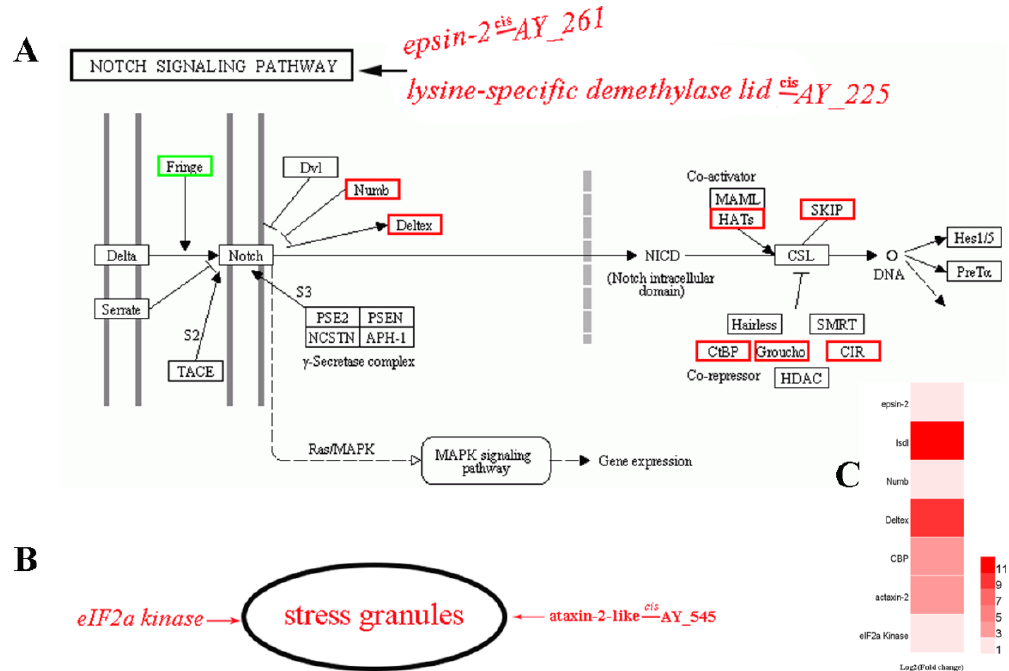
Figure 7. DEGs that are located in the neighborhood (putative cis -targets) of DELs and that are associated with Notch signaling pathway and stress granule formation. ( A ) Some DEGs including Numb, Deltex, CBP, Epsin-2 and lysine-specific demethylase lid ( lsdl ) that are associated with Notch signaling are increased in expression during ApNPV infection. As also shown in Figure 6, epsin-2 (evm.TU.AY_261.18) and lysine-specific demethylase lid (XLOC_008622) are considered as putative cis -targets of AY_261_133645_148170 and AY_225_415711_427236, respectively, in A . pernyi . Therefore, we speculate that AY-261 and AY-225 might participate in the regulation of the Notch signaling pathway by regulating the expression of epsin-2 and lysine-specific demethylase lid by a mechanism in cis . ( B ) Stress granule formation can occur as a result of eIF2 α phosphorylation caused by eIF2a kinase. eIF2a kinase expression was activated during ApNPV infection in A . pernyi . Ataxin-2-like protein, a neighboring gene and potential cis -target of AY_545, is a component of stress granules and could possibly function as a regulator of stress granules during ApNPV infection. ( C ) Heat map of the relative expression of epsin-2, lsdl, Numb, Deltex, CBP, ataxin-2-like protein and eIF2a kinase in ApNPV-infected A . pernyi compared with uninfected